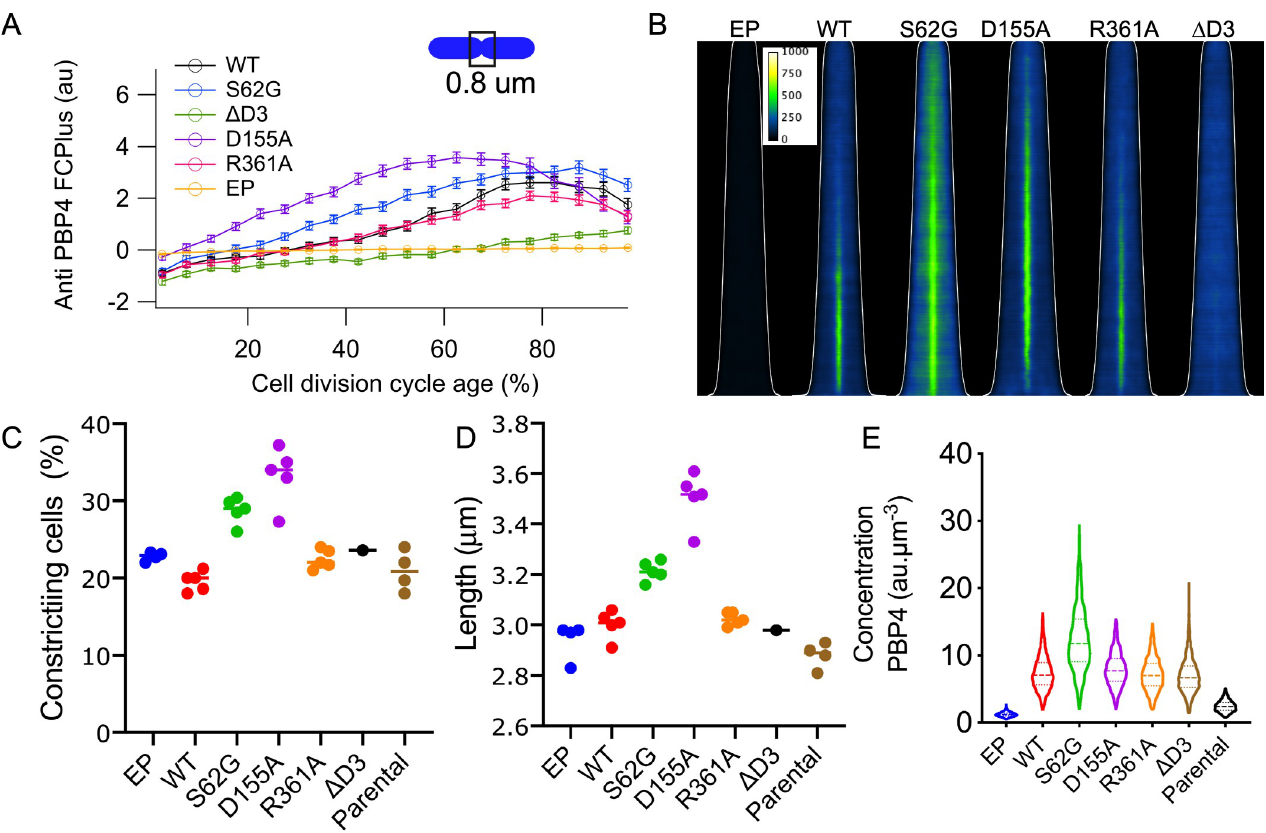
Fig 5. Localization of PBP4 depends on the presence of domain 3 but not on activity. Cells were grown in minimal glucose medium to steady state at 28˚C, fixed and immunolabeled with antibodies against PBP4. (A) The extra fluorescence at midcell (FCPlus) in the Δ dacB strain transformed with the empty plasmid (EP, yellow), or plasmids expressing wild-type PBP4 (black), PBP4S63G (blue), PBP4D155A, (purple) PBP4R361A (red), PBP4 Δ D3 (green) was determined and plotted as function of the cell division cycle age as in bins of 5% age classes with the error bar indicating the 95% confidence interval. (B) Demographs of the localization fluorescence pattern of the PBP4 variants shown in (A) with the cells sorted according to their cell length. The white line indicates the length of the cells. Intensity scaling is identical for all demographs. Number of cells analyzed for each immunolabeling was at least 2000 cells. Graphs with the percentage of constricting cells (C) and the average cell length in μ m (D) for the various mutants expressed from plasmid without induction in the Δ dacB strain and of the parental strain BW24113 (n = 4). (E) The concentration of PBP4 in fluorescence units per μ m 3 in these cells for a representative experiment (out of the four